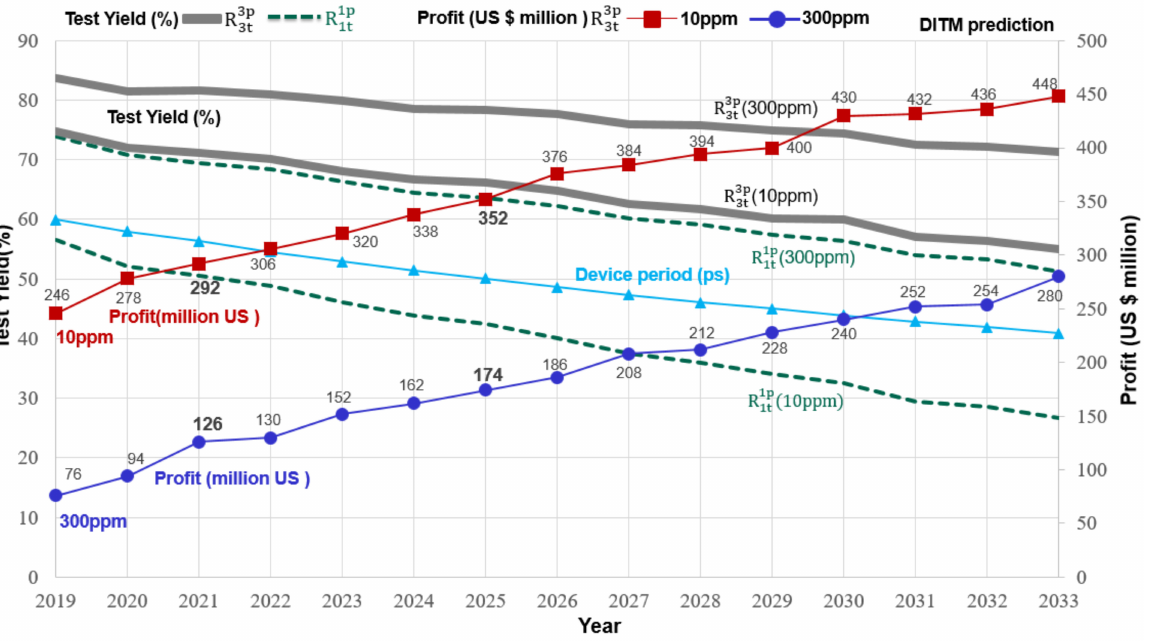
Figure 11. Three-repetition tests scheme (TRTS) improves test yield and overall company